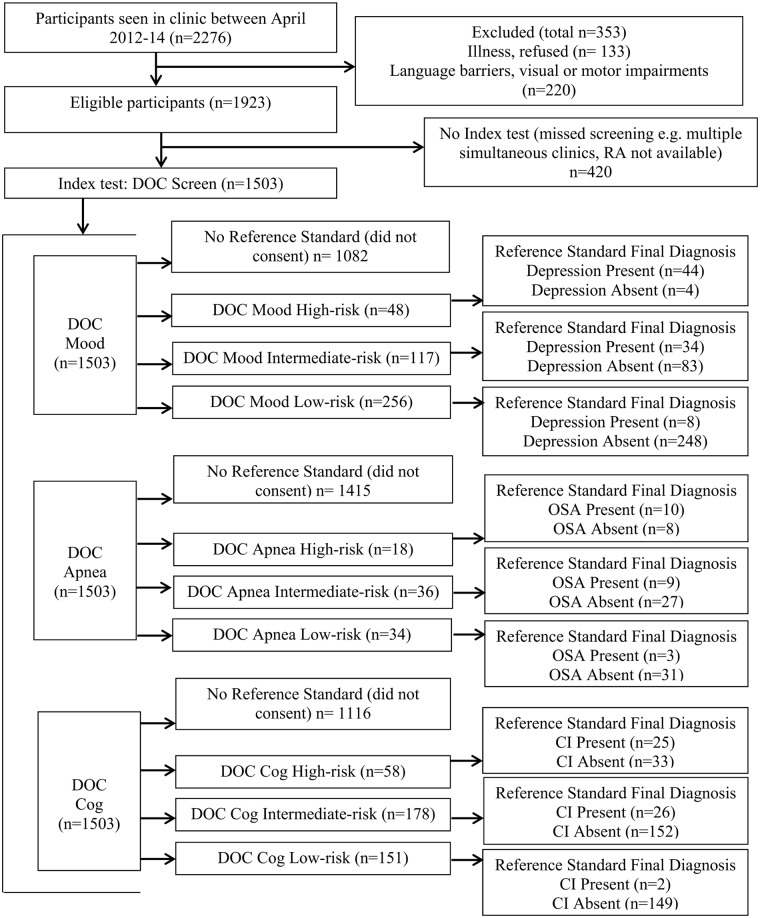
DOC study patient flow.Impairment on the reference standard was determined using the two cut-point regression method.